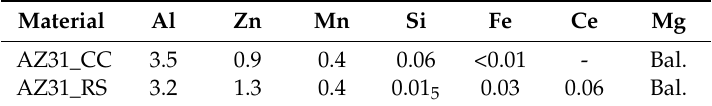
Table 1. Chemical composition of materials used (in wt